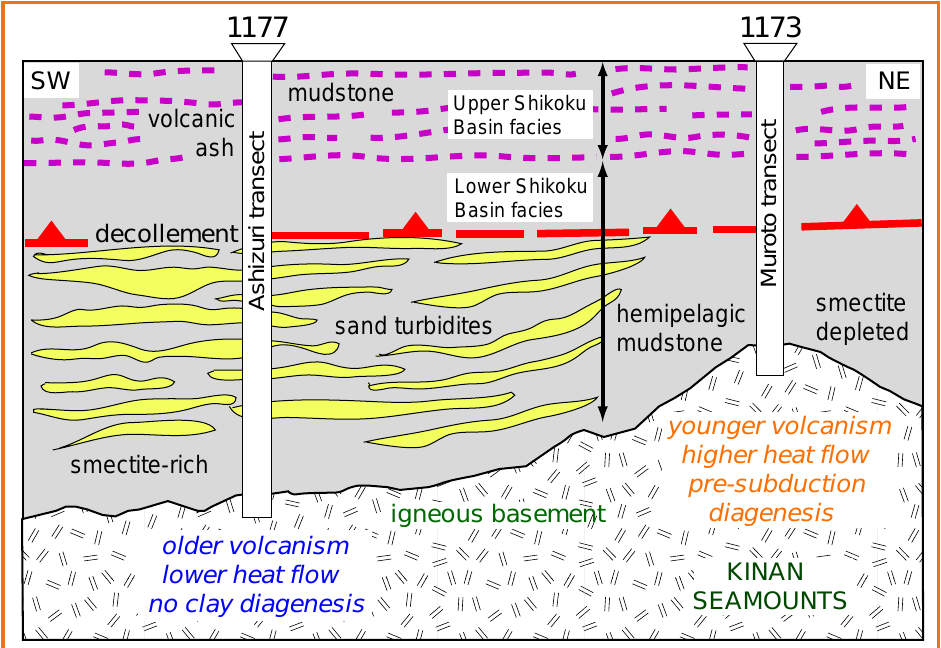
Figure 1. Schematic cross-section through ODP Sites 1177 and 1173 near the subduction front of the Nankai Trough. The plane of the section is oriented parallel to the strike of the margin and shows pinch-out of Miocene to Pliocene turbidites against the paleo-seafloor and basement relief of the Kinan